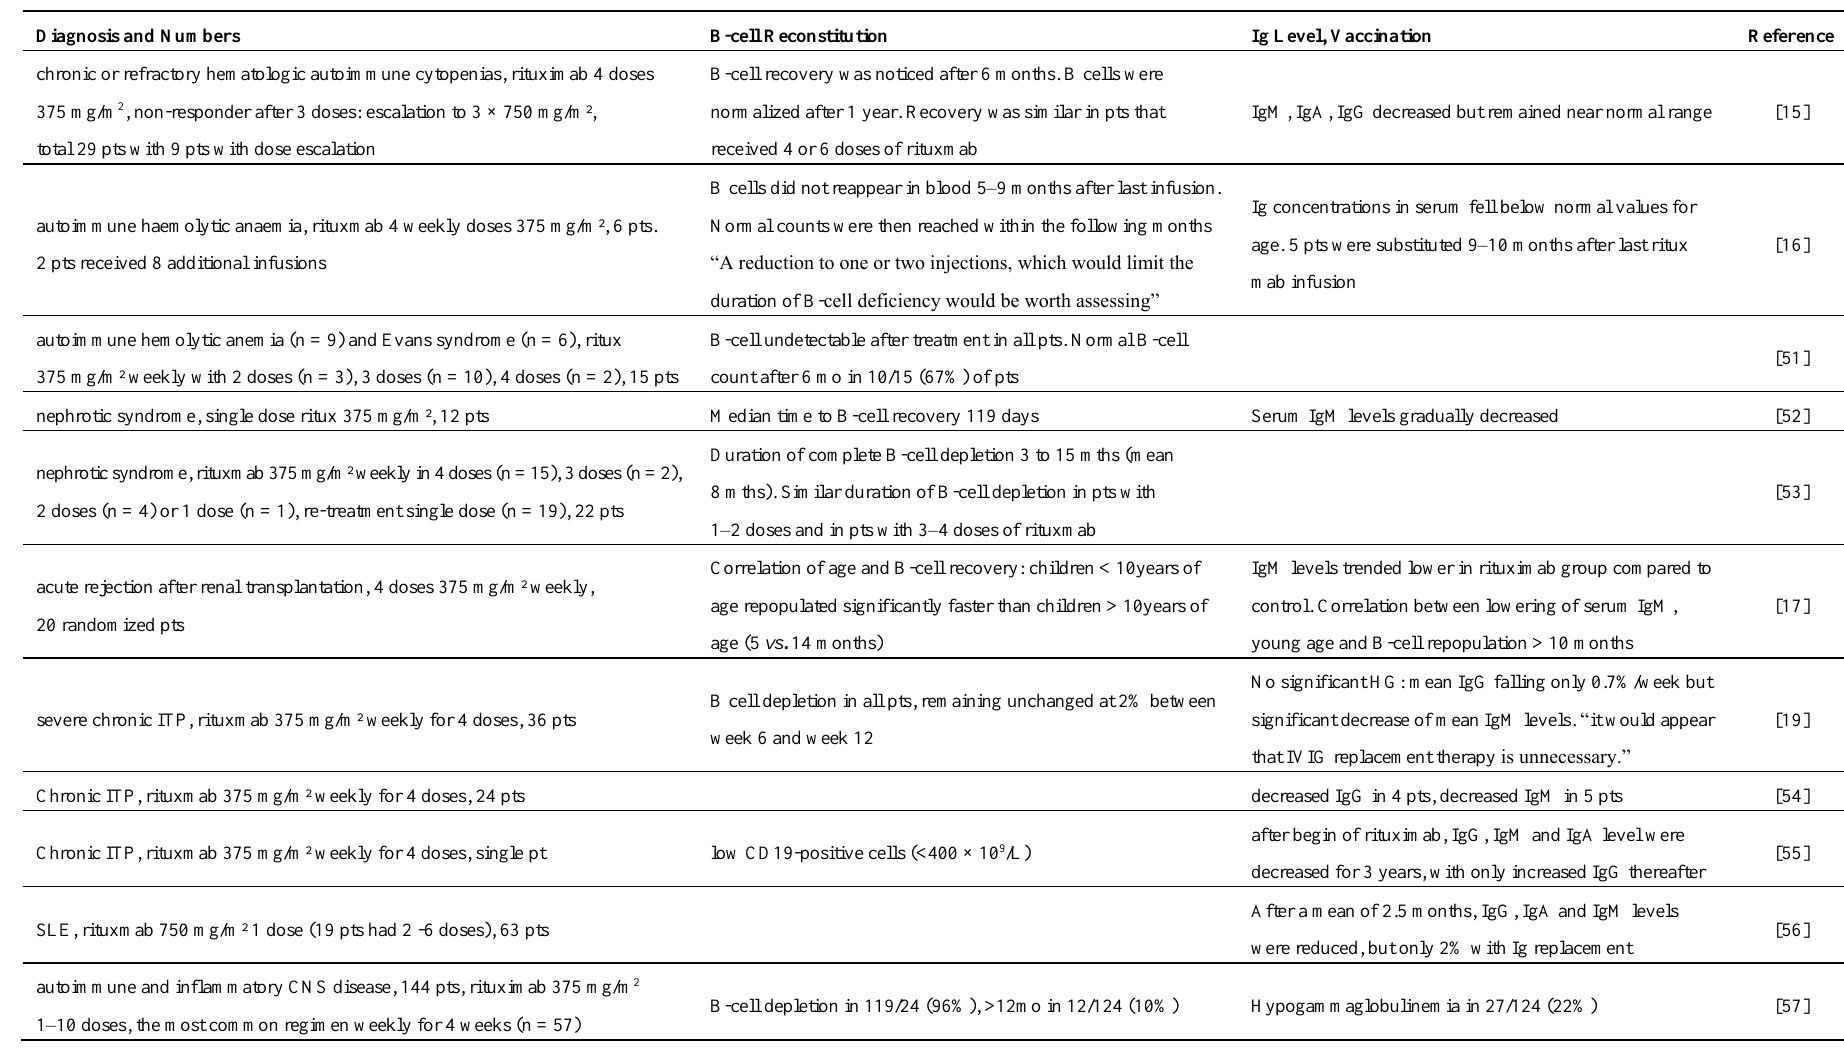
Table 1. Immunreconstitution and immunoglobulin levels after rituximab therapy in children and adolescents with non-malignant diseases. Diagnosis and Numbers B-cell Reconstitution Ig Level,